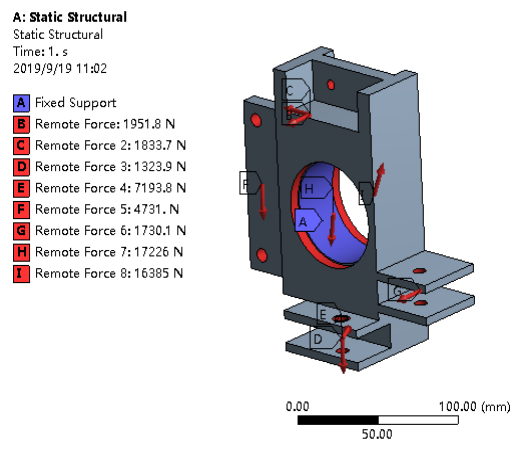
Figure 2. The initial geometric model.